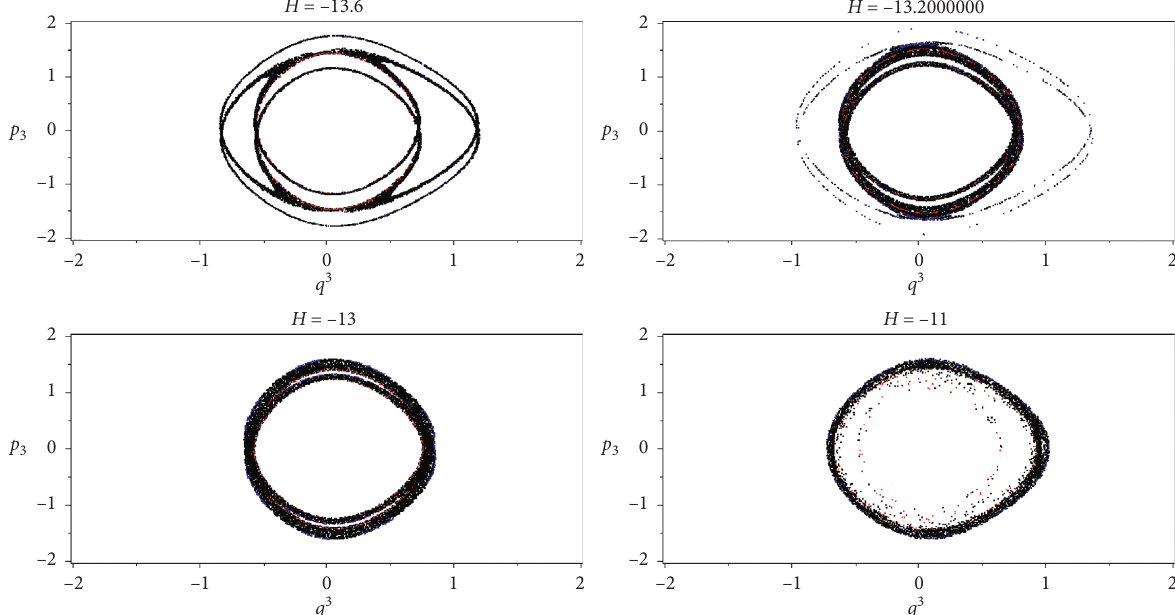
Figure 15: The progressive transformation of a Poincar´e surface of sections for different energy levels in the equal masses case � 5 . 17662, m � 1, b � 1 . 9, and c � 0 . ( m 0